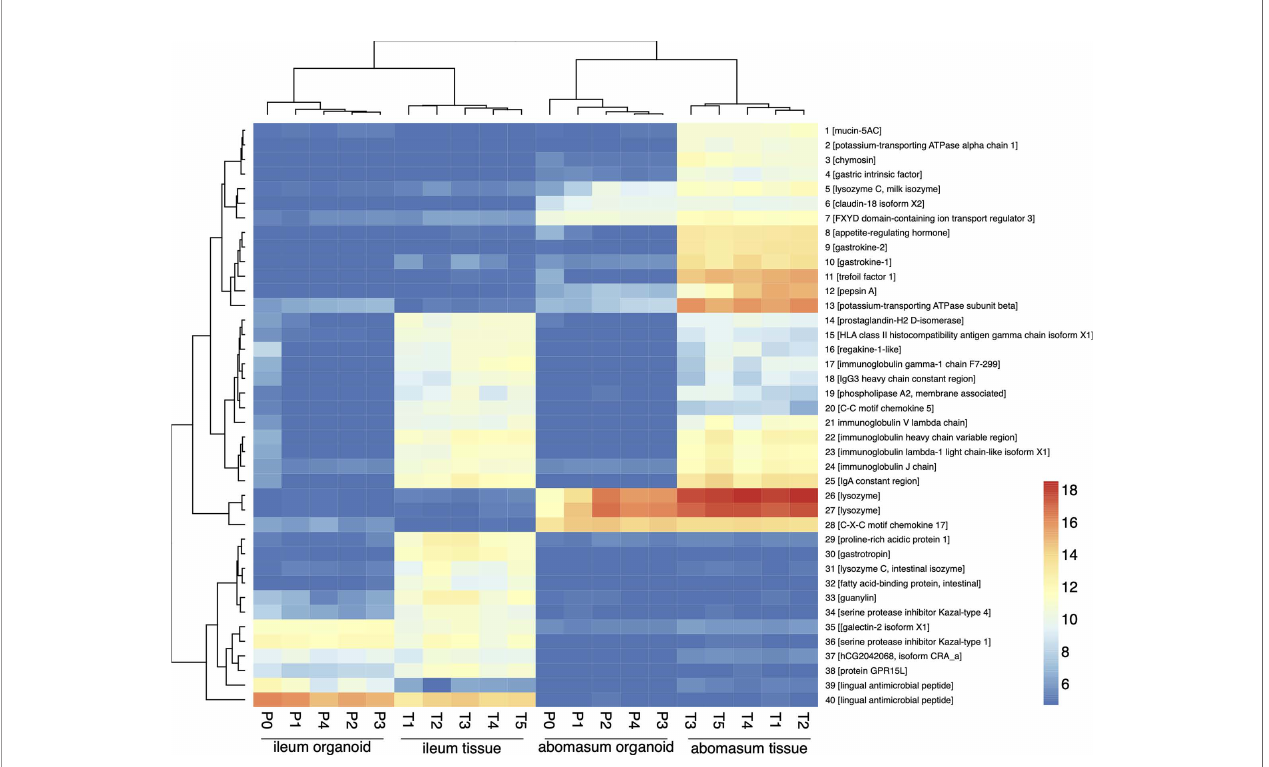
FIGURE 6 | Heat map showing expression level of top 40 most variant genes (of genes ranked by inter-sample variance) from ileum (ile) and abomasum (abo) organoids from serial passages (P0 – P4) and ileum (ile) and abomasum (abo) tissue derived from fi ve lambs (T1 – T5). Colours indicate level of expression from low (blue) to high (red). The dendrograms indicate similarity between samples. Details of genes included in the heat map, including ENSOART sequence identi fi ers, are shown in Supplemental File 1